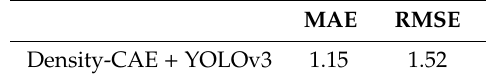
Figure 15. Continuous image analysis for the evening. Table 4. Evaluation of continuous image model for the evening.